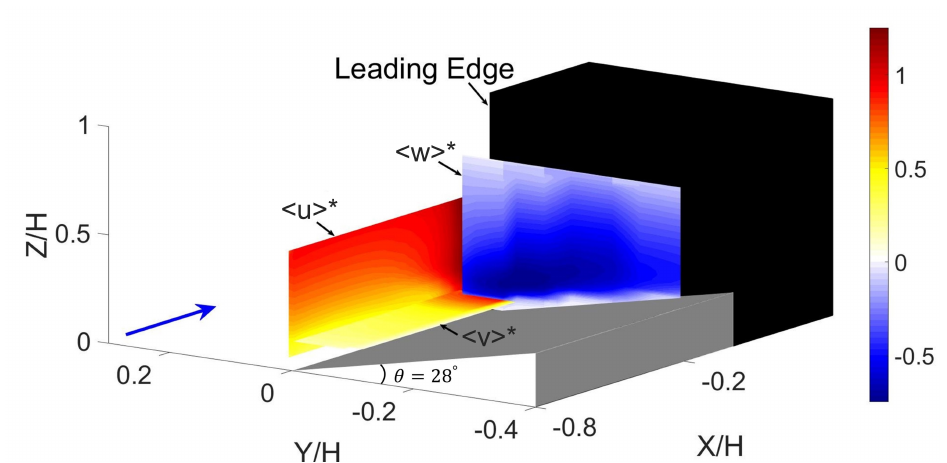
Figure 3. Dimensionless time-averaged streamwise (< u >*), lateral (< v >*), and vertical (< w >*) flow velocity fields within the representative planes in the immediate vicinity of the retaining wall. The flow direction is shown by a blue